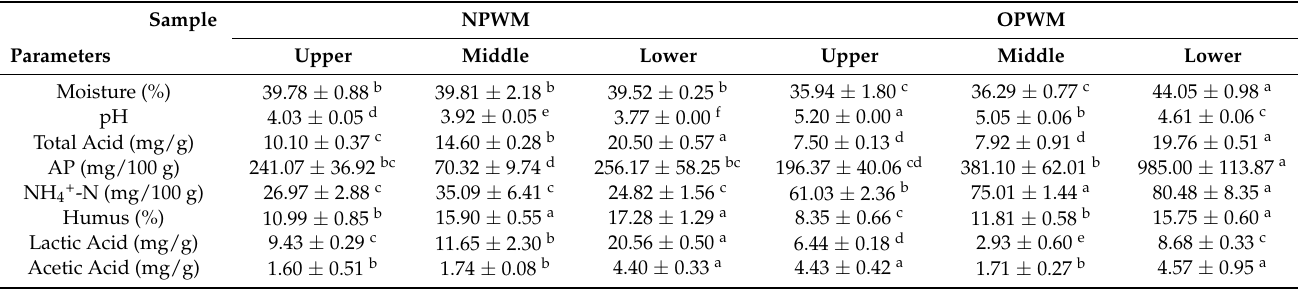
Figure 2. ( A ) Wilcoxon rank-sum test performed on the basis of a two-tailed test and false discovery rate correction revealed 15 bacterial genera with different abundances (difference > 10%) in new (red) and old (blue) pit-wall mud samples. Significance levels are denoted as follows: ** p < 0.01 and *** p < 0.001. ( B ) Correlation networks observed between the 15 bacterial genera (Spearman correlation coefficient [r] > 0.5; p < 0.05). The red line indicates a positive correlation, whereas the green line indicates a negative correlation. The thickness of the lines indicates the values of the correlation coefficients. Table 1. Physicochemical properties of PWM samples. The superscript letters (a–f) on the upper-right side of the values mean the significant differences between PWM